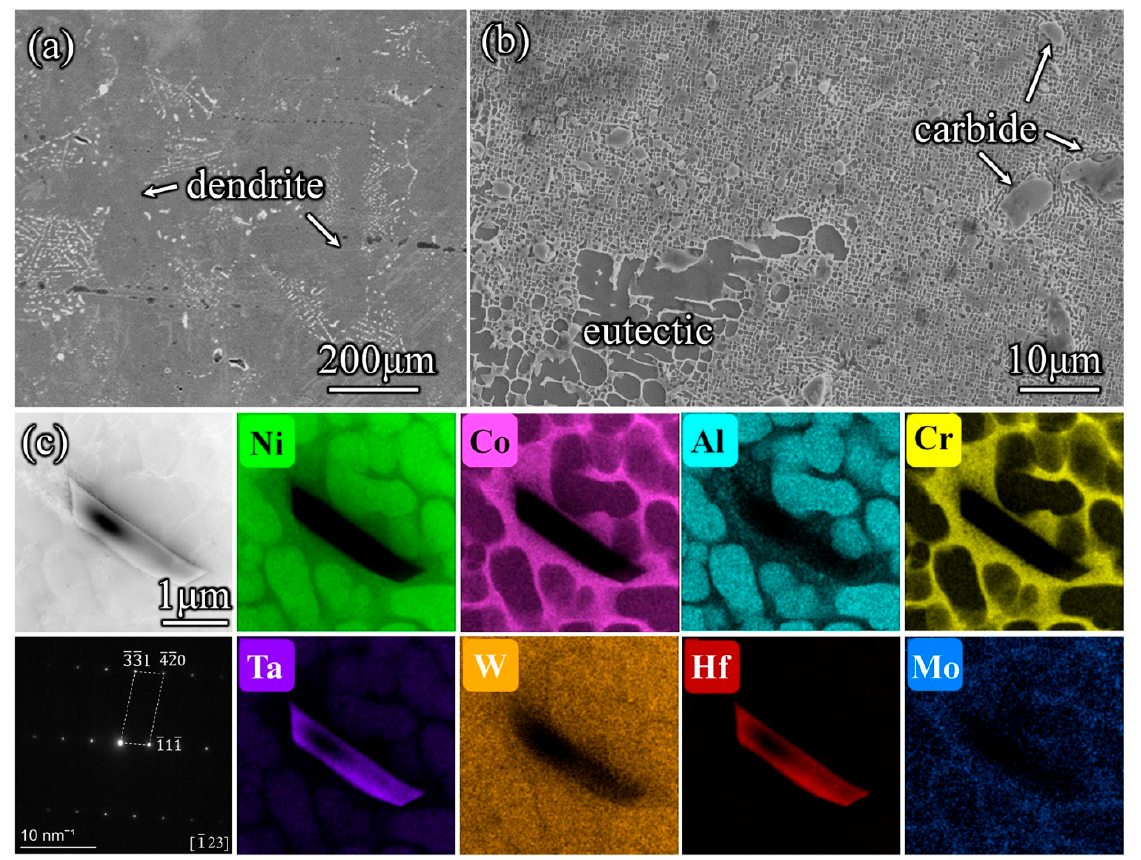
Figure 1. Microstructure of the shank position. ( a ) SEM image of dendrite structure. ( b ) SEM image of the inter-dendrite structure containing eutectic and carbide. ( c ) Phase analysis and element distributions of carbides.